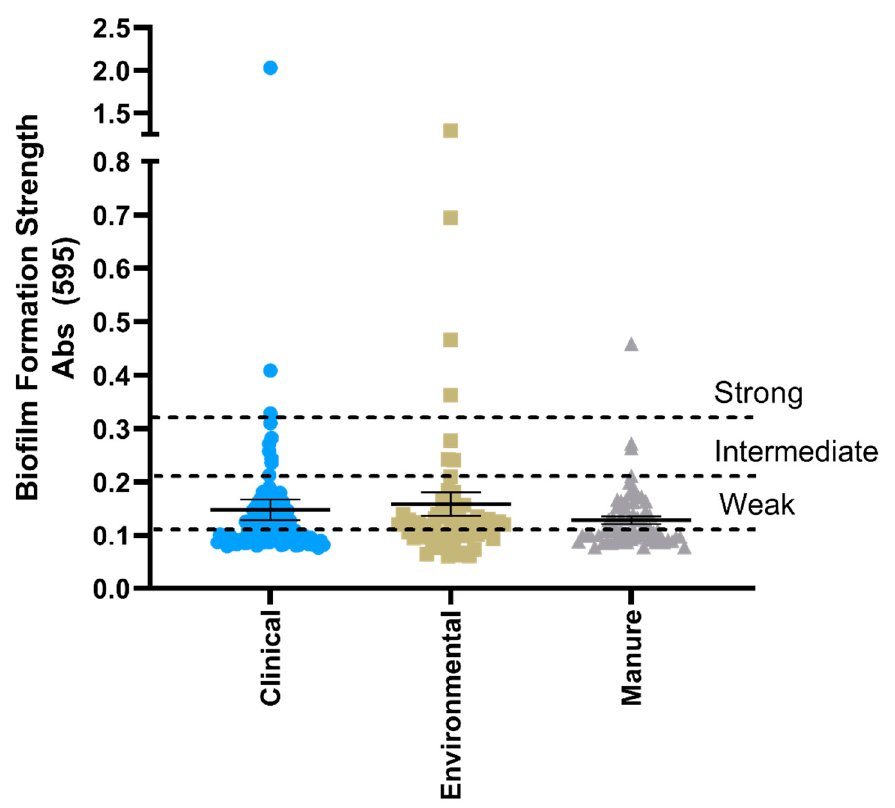
Figure 3. Biofilm formation strength of E. coli isolates as measured by absorbance of crystal violet staining. Isolates are presented as individual values with the mean and standard error of each source plotted. Strong, intermediate, and weak biofilm former classification is defined in Section 2.7, Materials and Methods.